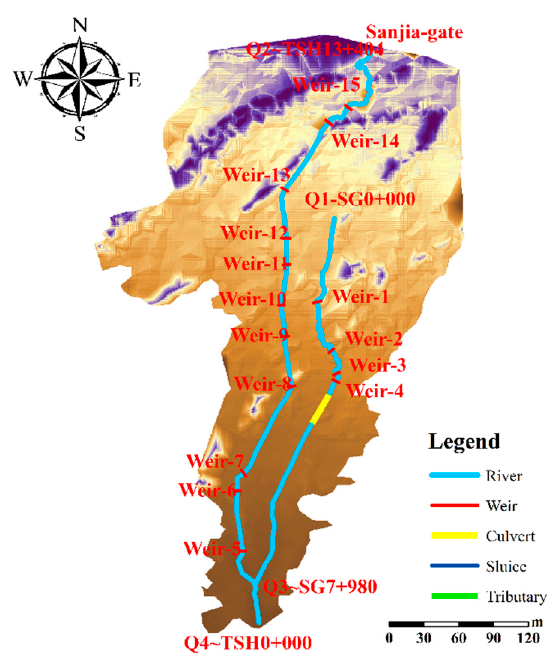
Figure 3. River generalization map of the study area.